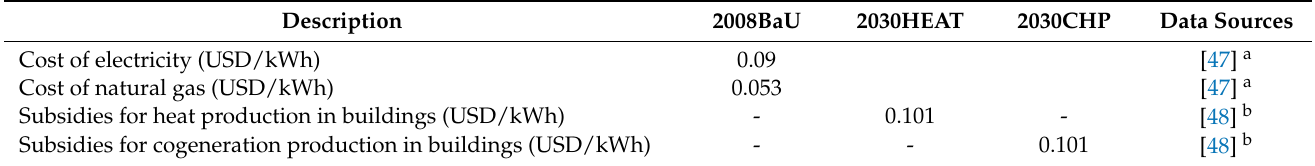
Table 1. Costs and subsidy amounts considered for 2008 and 2030, in US dollars